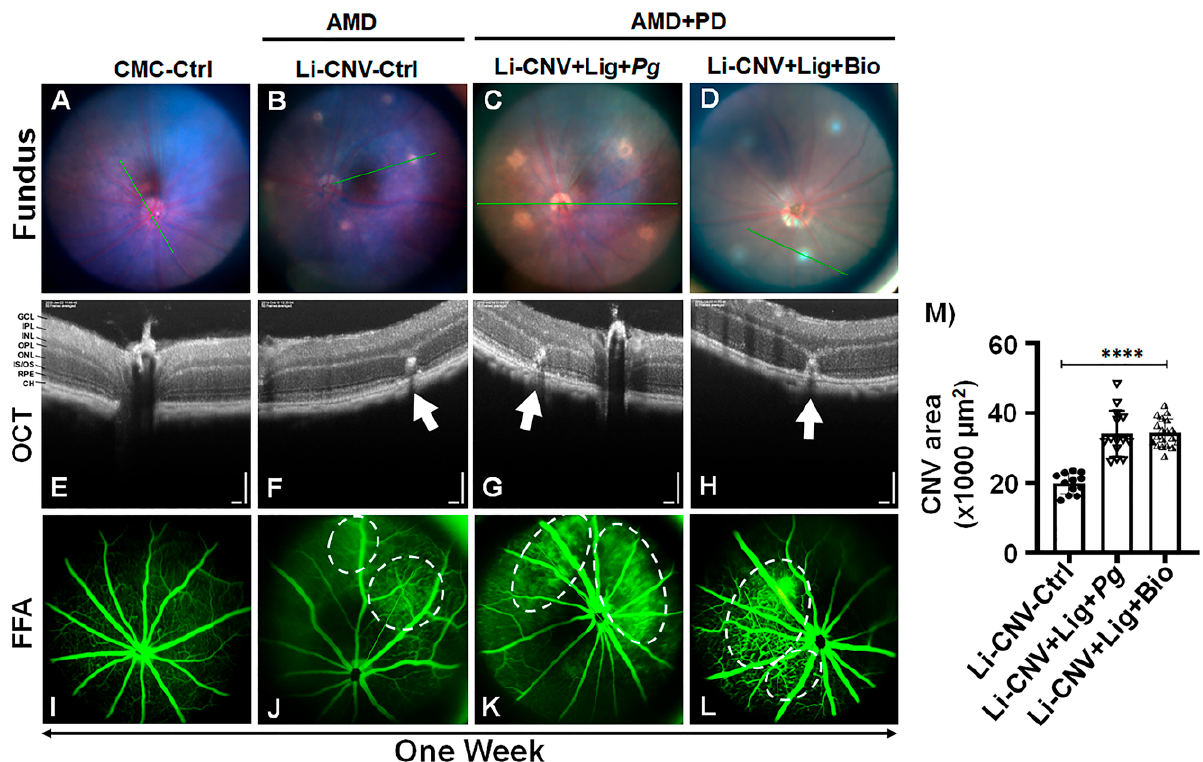
Figure 2. Increased retinal vascular leakage by oral pathogens in AMD+PD mice retinae. ( A – D ) Representative fundus photography from mice before and after laser in a subsequent week. Fundus show ( A ) CMC-control group (2% CMC, no bacteria) and spots of laser burn ( B ) Li-CNV control, ( C ) Li-CNV+Ligature+ Pg , and ( D ) Li-CNV+Lig+Biofilm after 1 week (n=24). The green lines indicate the scan lines of SD-OCT sections. ( E – H ) Representative images of SD-OCT and ( I – L ) fundus fluorescein angiography (FFA) after 1 week of CMC-control, Li-CNV-Control, Li-CNV+Lig+ Pg , and Li- CNV+Lig+Biofilm-infected mice retinae, respectively. ( F – H ) OCT shows rupture of Bruch’s membrane (BM, white arrows) induced by laser burn compared to CMC-control. Refer the low-magnification image for the complete view (Figure S1). Representative FFA images after injection of fluorescent dye 1 week post laser burn ( J – L ) and CMC-control ( I ). FFA demonstrates increased blood leakage (white circle) in Pg ( K ) and biofilm ( L ) infected after 1-week compared to Li-CNV- control ( J ). Refer Figure S1 for another set of representative FFA images. ( M ) Quantification analysis shows increased CNV areas in Pg - and biofilm-infected mice retinae after 1 week compared to CNV control. Mean ± SEM analyzed by one-way